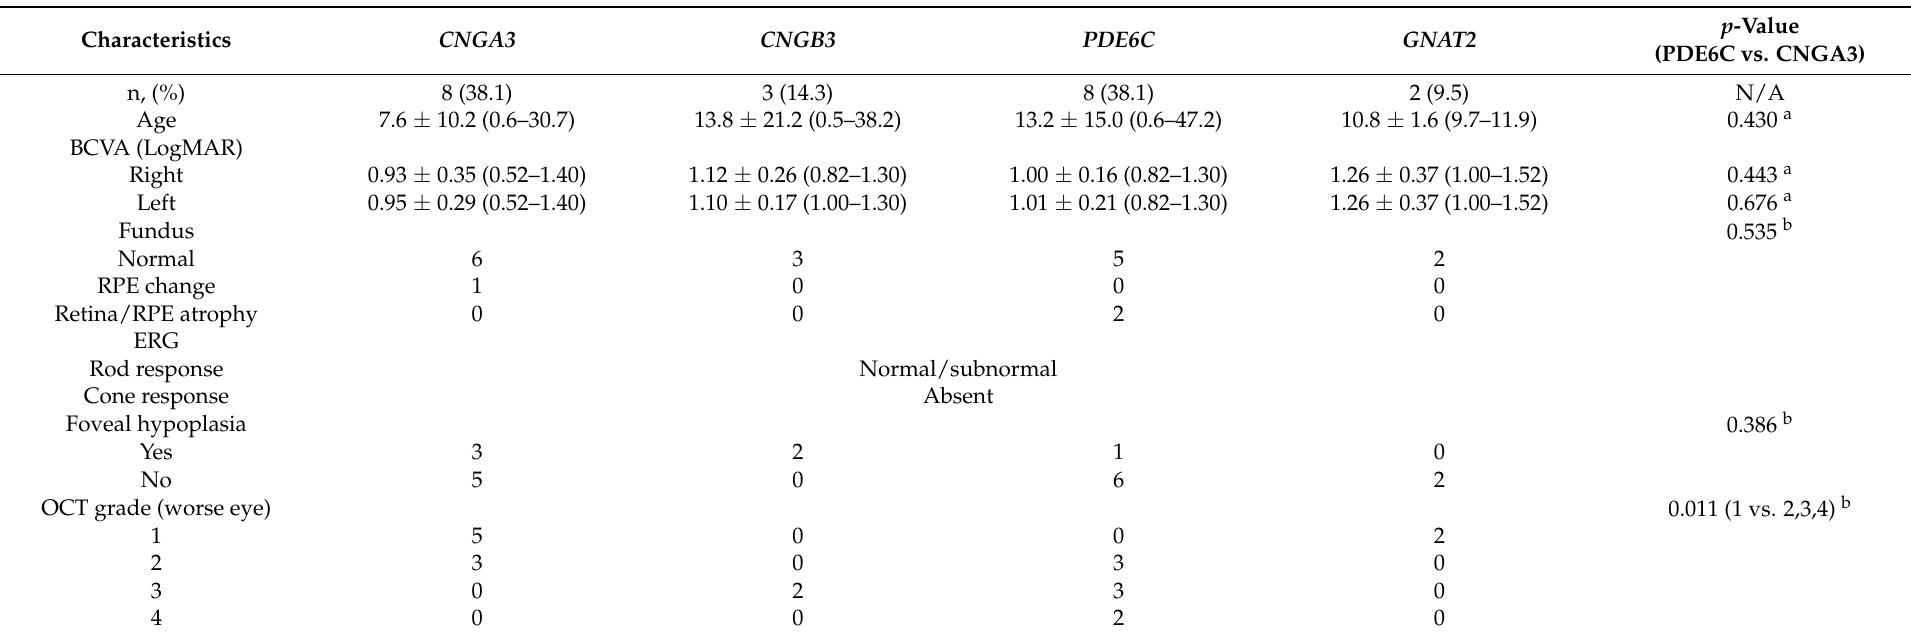
Table 4. Comparison of patients with achromatopsia who were grouped by the causative genes with